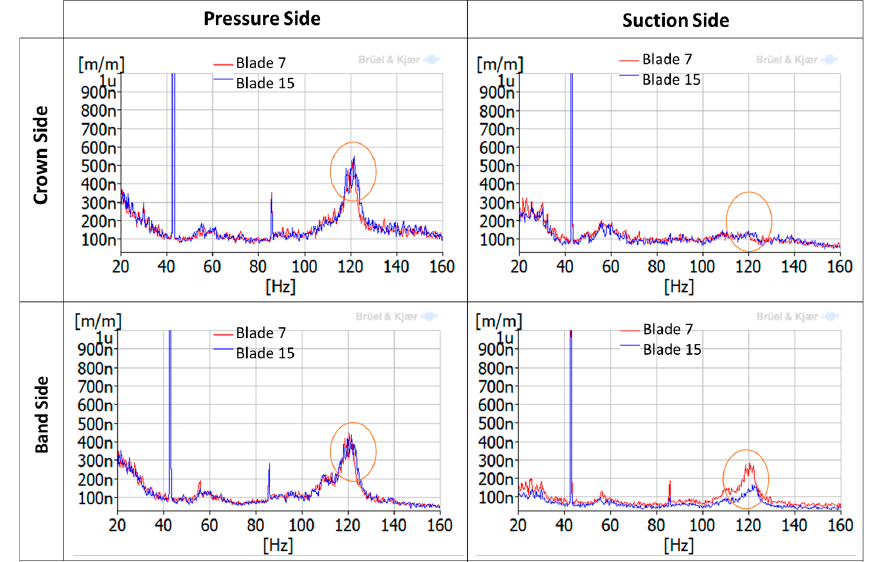
Figure 12. Averaged-spectrum analysis of a different strain gauges during DPL (18% of rated power).